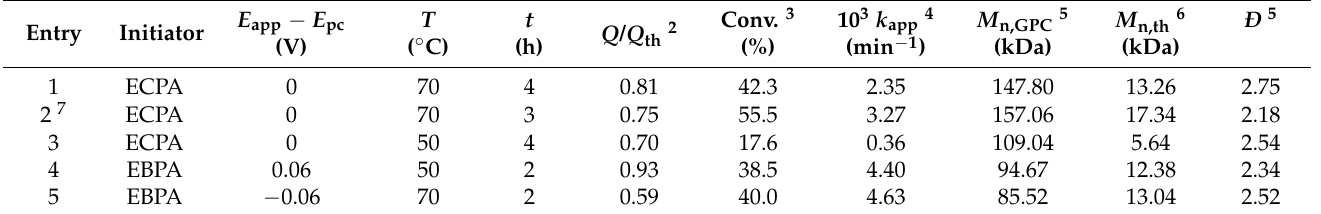
Table 2. e ATRP of methyl methacrylate (MMA) in DMF/monomer (50/50, V/V ) + 0.1 M Et 4 NBF 4 1 .